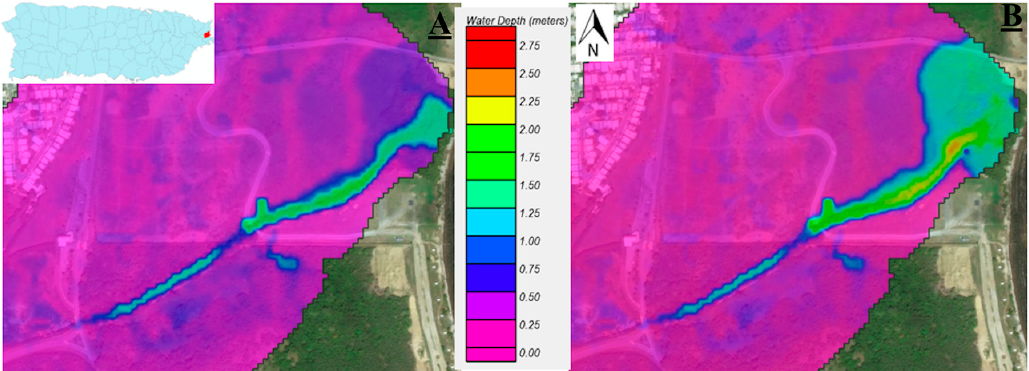
Figure 12. Maximum flood depth for the different flooding scenario at the Aguas Claras Creek watershed. ( A ) Without storm surge inland penetration; ( B ) Considering storm surge inland penetration. The color scale represents the water depth in meters, where the red color indicates the maximum value and the magenta color represents the minimum value.